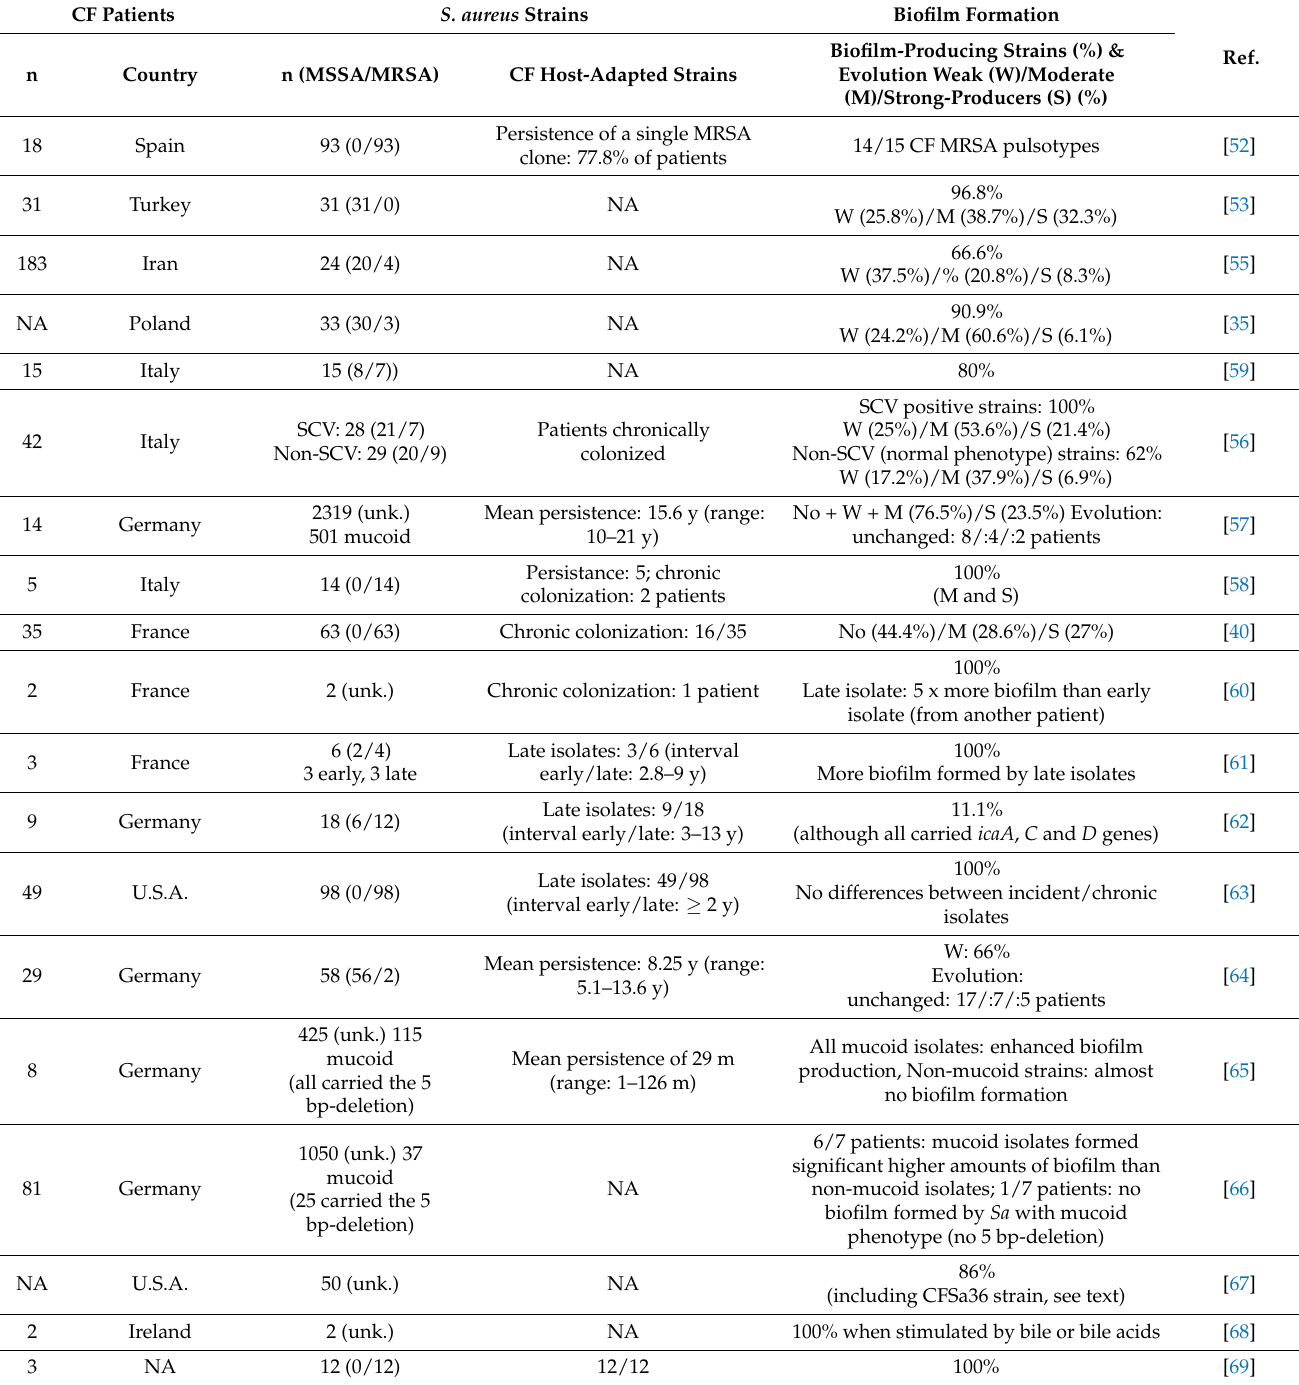
Table 1. Summarized presentation of studies on biofilm formation by clinical strains of S. aureus isolated from patients with Cystic